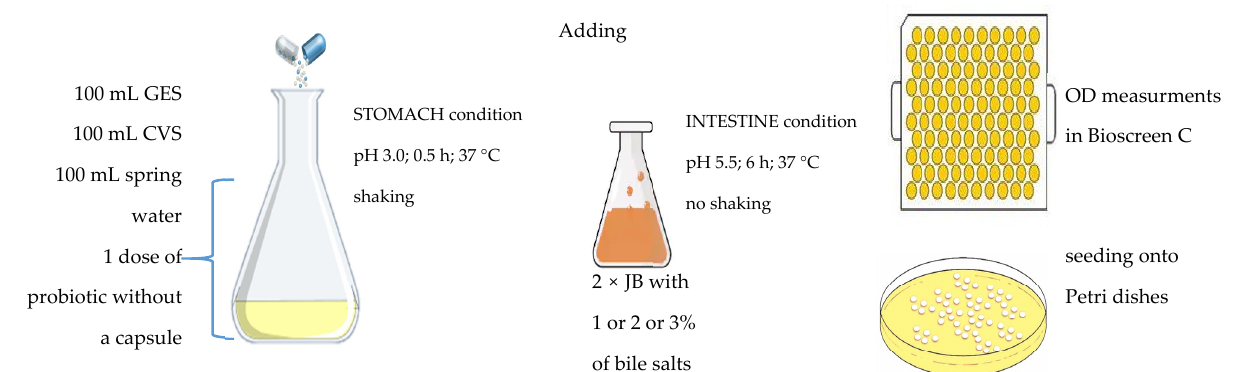
Figure 2. Scheme of the variants tested under gastrointestinal stage of experiment, (GES—gastric electrolyte solution, CVS—chicken–vegetable soup, 2 × JB—2 × concentrated J broth).